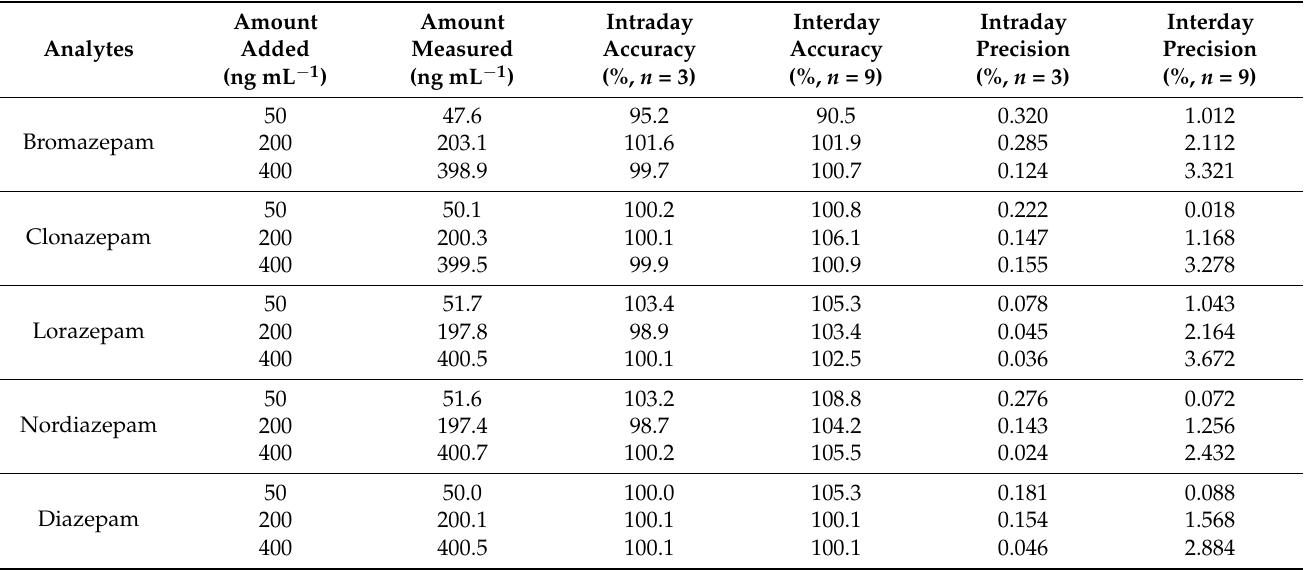
Table 2. Accuracy expressed as recovery (%) and precision, expressed as relative standard deviation (RSD, %), of the developed RPLC methods for the analysis of selected